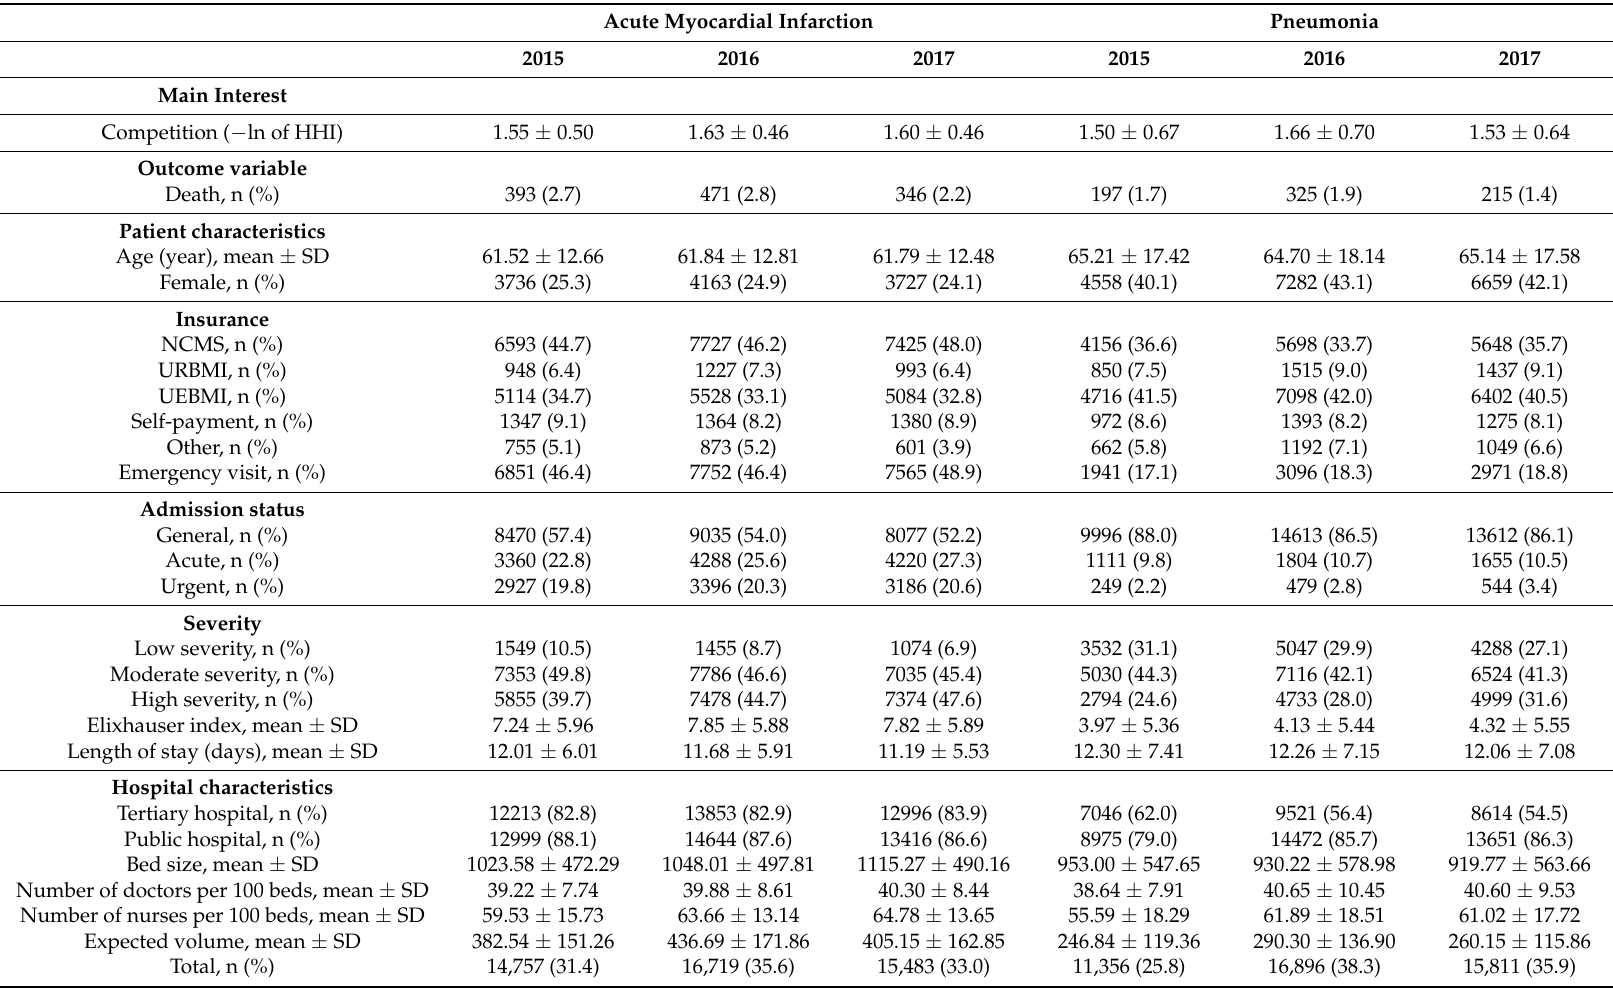
Table 1. Descriptive statistics of the patient and hospital characteristics,